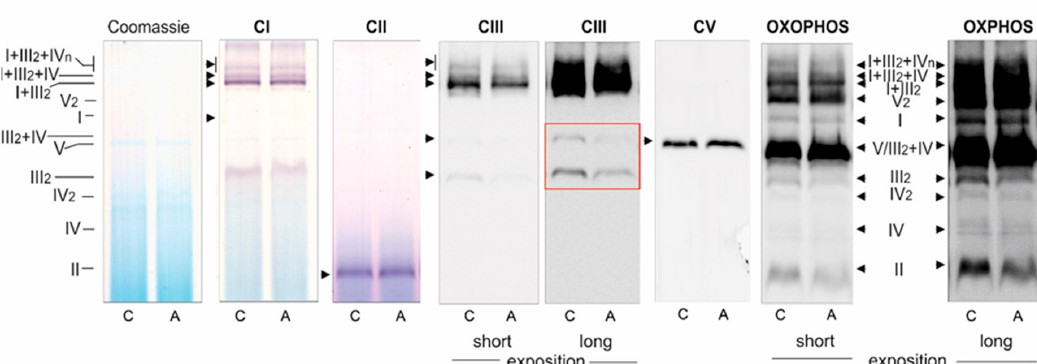
Figure 6. Blue Native (BN)-PAGE showing oxidative phosphorylation (OXPHOS) complexes and supercomplexes in mitochondria from control (C) and ATOR-treated (A) endothelial cells. Sequentially shown: Coomassie staining and destaining (loading control), CI in-gel activity, CII in-gel activity, CIII immunoblotting (short and long exposition), CV in-gel activity, and total OXPHOS immunoblotting (short and long exposition). CI–CIV: respiratory chain complexes I-IV; CV: ATP synthase.